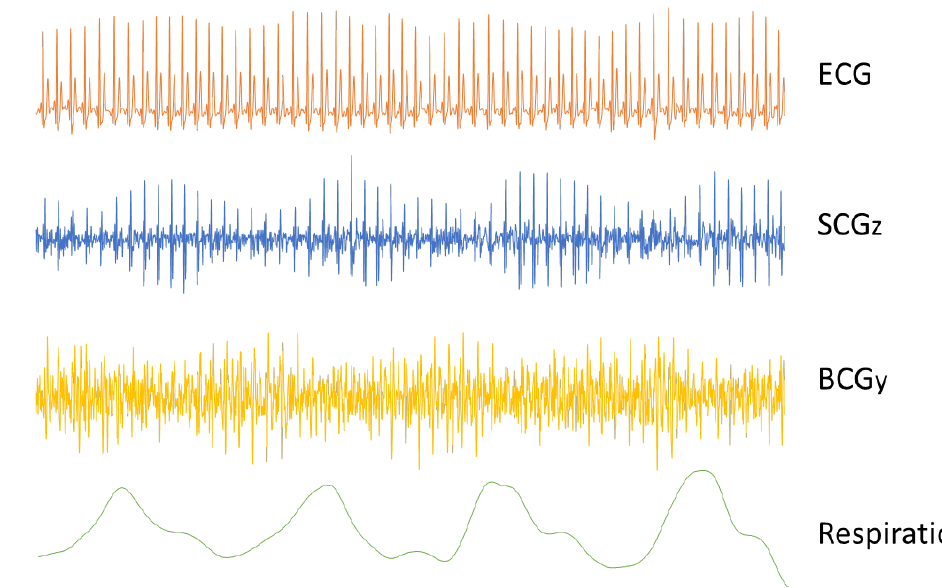
Figure 4. Respiratory variations of the SCG and BCG signals. The time traces of an ECG, SCG (dorsoventral direction), and BCG (head-to-foot direction) are plotted against the concurrently recorded respiration signal. The SCG signal is visibly affected by breathing, with higher amplitudes during expiration than during inspiration. Opposite changes are also visible in the amplitude of the BCG signal, decreasing during expiration.